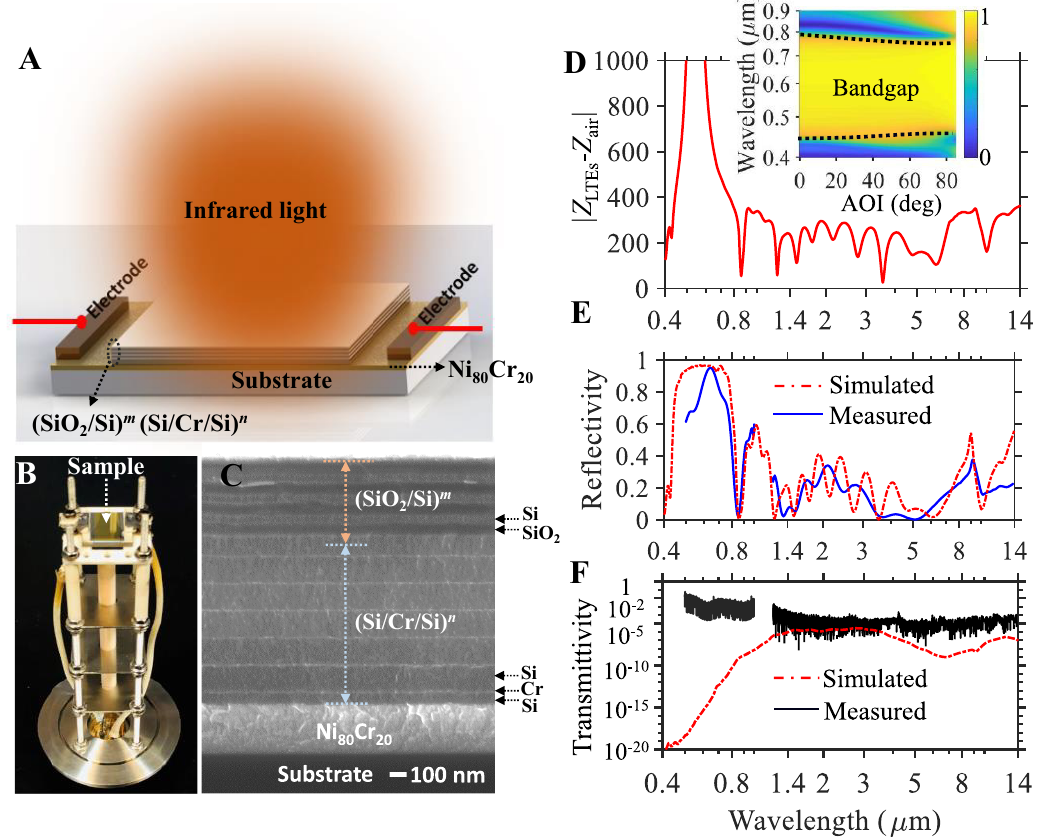
Figure 1: The concept, and the theoretical and experimental implementation of the selectively broadband metamaterial thermal emitters. (A) Schematic diagram of the LTEs, where two 1D photonic lattices with structures of (Si/Cr/Si) n and (SiO 2 /Si) m are lying on top of a Ni 80 Cr 20 nanolayerdepositedonaquartzsubstrate.VoltageisappliedtotheNi 80 Cr 20 layertogenerateJouleheattoraisethetemperatureofthewhole device. Here, m and n represent the number of the periods of the two lattices. (B) Photography image of the fabricated devices mounted on a sample holder. (C) SEM image of the cross section of the LTEs. (D – F) The characteristic impedance mismatch | Z LTEs − Z air | , and the re fl ectivity and the transmissivity spectra, respectively. The inset of (D) depicts the re fl ectivity spectra versus angle of incidence (AOI) of the (SiO 2 /Si) m . ThegeometricparametersoftheLTEsare:thethicknessofeachSi(SiO 2 )layerinthe(SiO 2 /Si) m is40nm(100nm),andthethicknessofeachSi (Cr) layer in the (Si/Cr/Si) n is 100 nm (4 nm); the number of periods m and n are 4 and 6, and the thickness of the Ni 80 Cr 20 layer and the substrate is 300 nm and 0.5 mm,